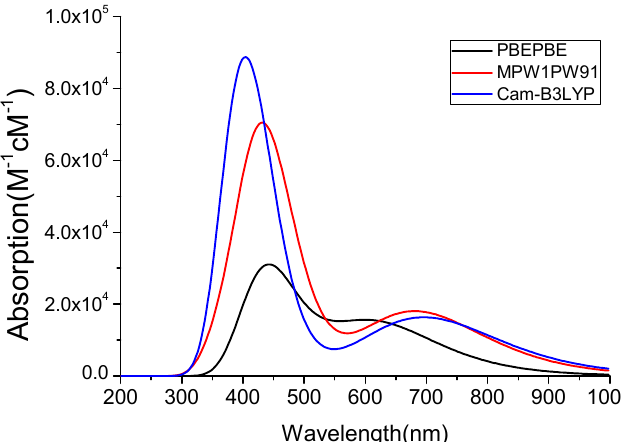
Table 3. Calculated excitation energies ( E , eV), absorption peaks ( λ (cid:2911)(cid:2912)(cid:2929) , nm), electronic transition configurations and corresponding oscillator strengths ( f ) of chlorophyll a in ethanol by using TD-DFT//PBEPBE/6-31G(d) method.